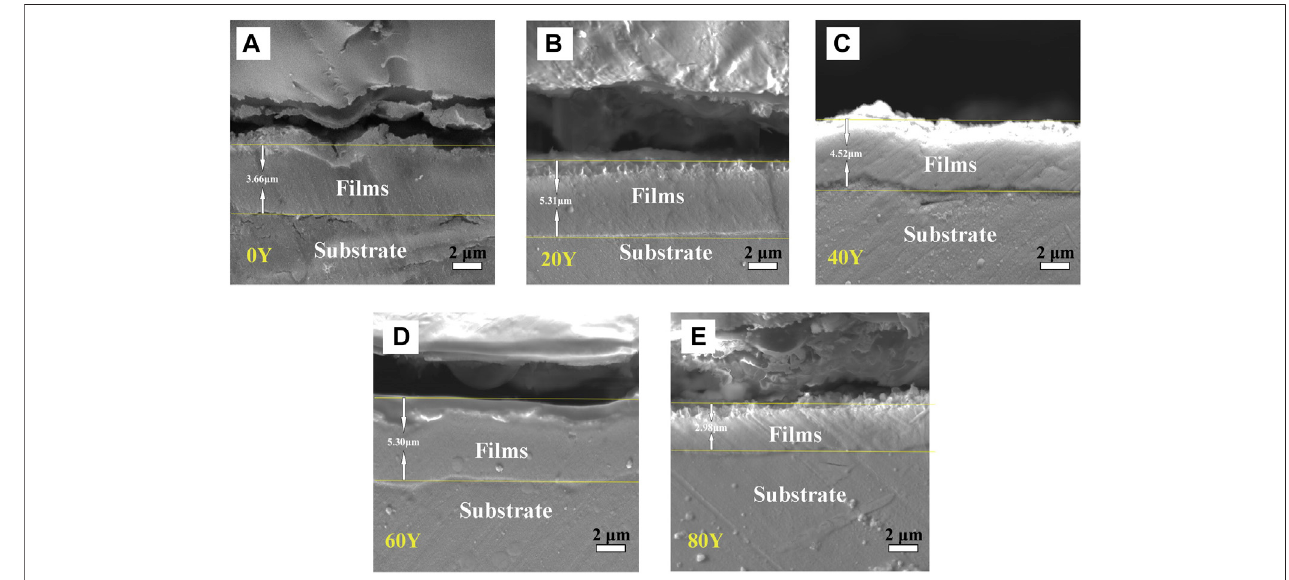
FIGURE 5 | Cross-sectional images of different specimens: 0Y (A) ; 20Y (B) ; 40Y (C) ; 60Y (D) ; and 80Y (E) .